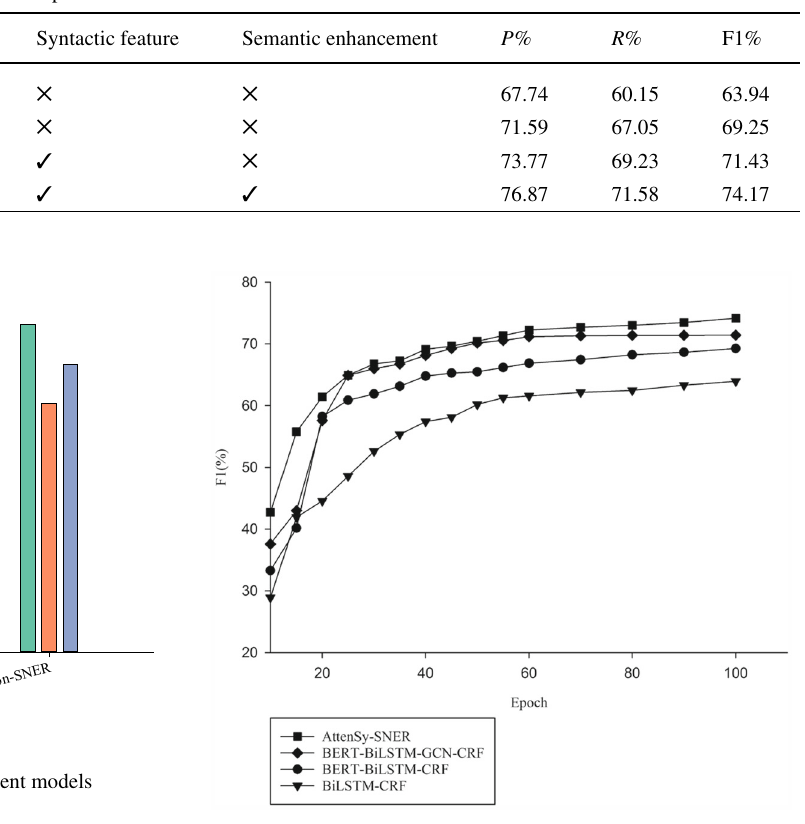
Fig. 9 The relationship of F1 score and